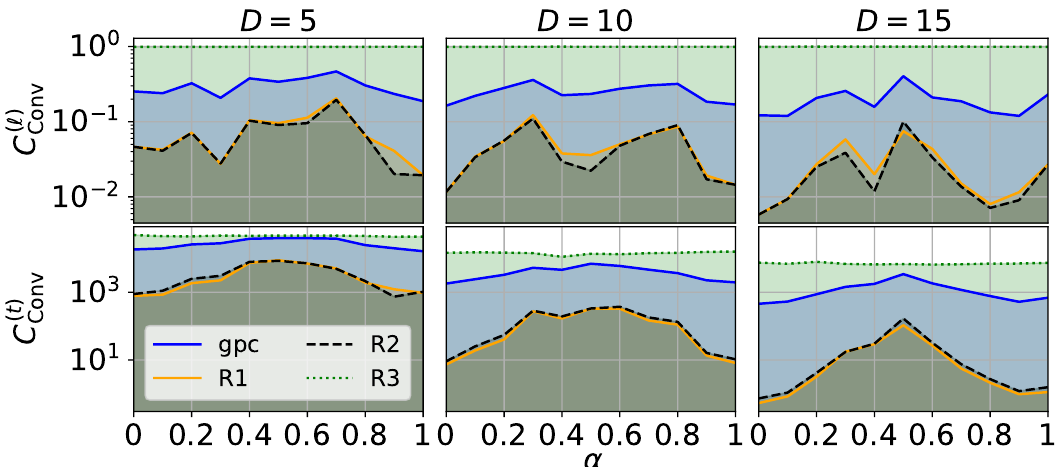
Figure 2: Convergence coefficients for ℓ -dependent (first row) and time-dependent (second row) flow for D -dimensional random matrices, see Sec. 4.3.2, for various crossover ratios α induced by the gpc-generator compared to the flows induced by the R1-, R2- and R3-generator averaged over 100 samples. The dimension D is given at the top of each